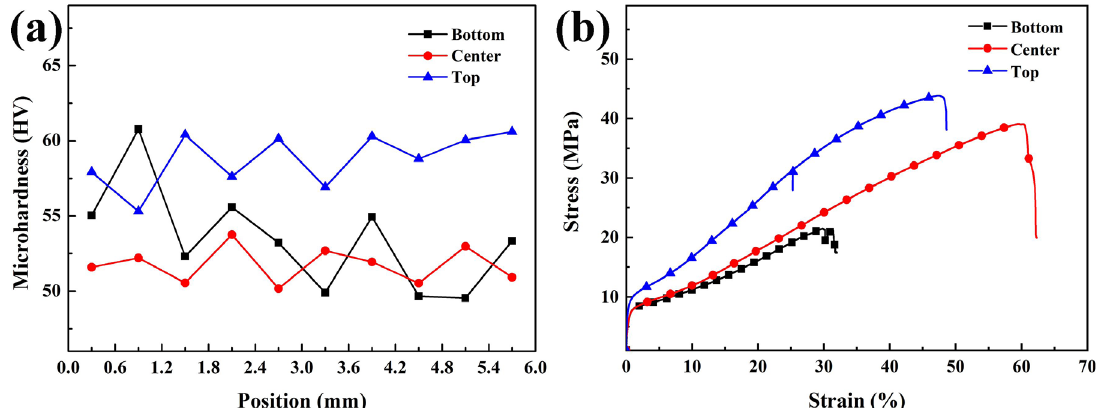
Figure 6. (a) Microhardness and (b) Room temperature tensile stress-strain curves of the different regions of the casting